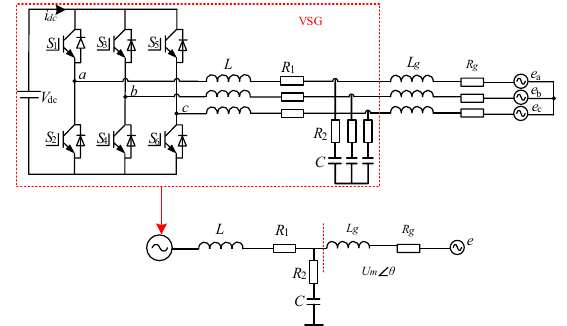
Fig. 1 Topological map of the inverter with output LC filter